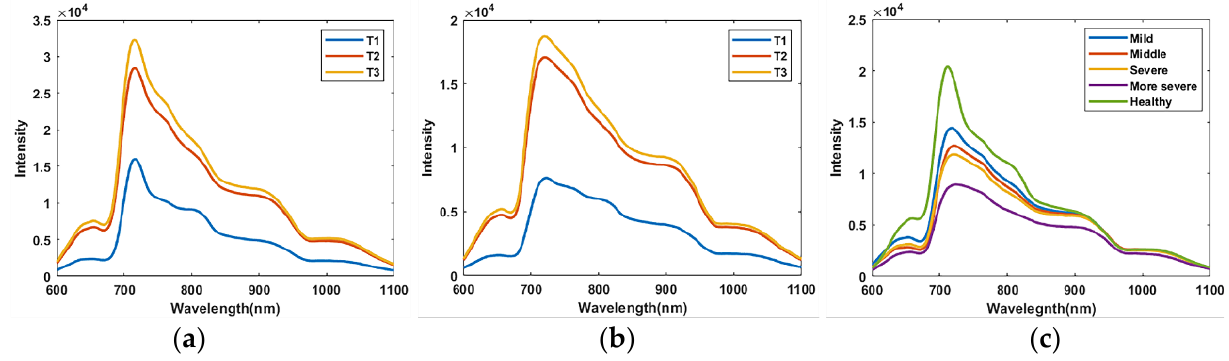
Figure 6. The raw energy stationary spectrum. ( a ) The average spectrum in three orientations of healthy apples; ( b ) the average spectrum in three orientations of diseased apples; ( c ) the spectrum of diseased apples with internal browning of varying degrees and a healthy apple.